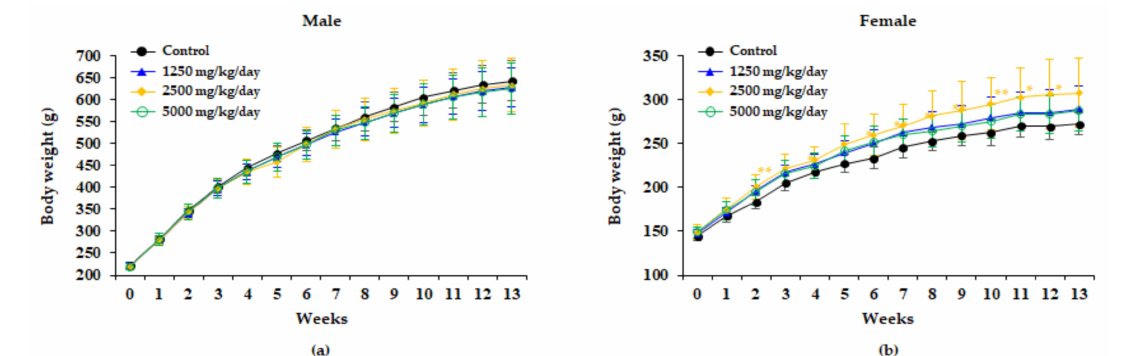
Figure 1. Bodyweight of male ( a ) and female ( b ) rats treated with 0, 1250, 2500, and 5000 mg/kg/day in the 13 weeks repeated oral dose toxicity study of WG extract. The results are presented as the mean ± standard deviation (n = 10). Significantly different from the control group at * P < 0.05, ** P < 0.01.